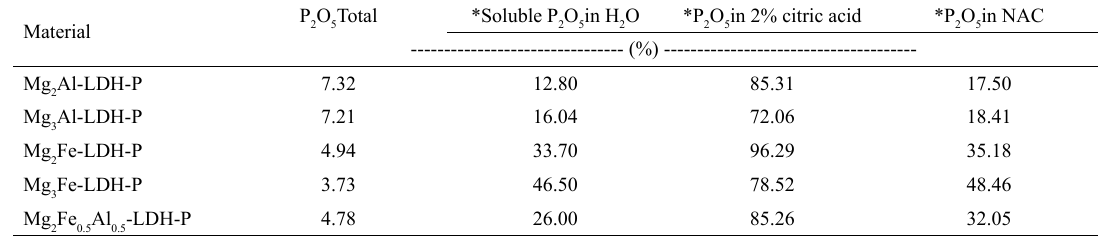
O , in water, 2% citric acid and neutral ammonium citrate (NAC) 2 5